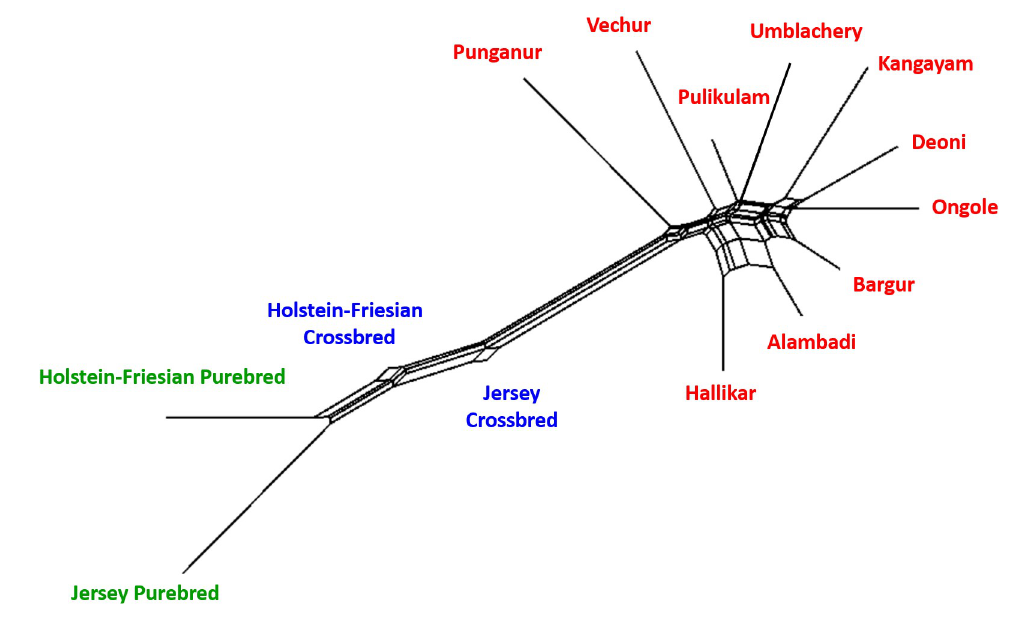
https://doi.org/10.1371/journal.pone.0246497.g002